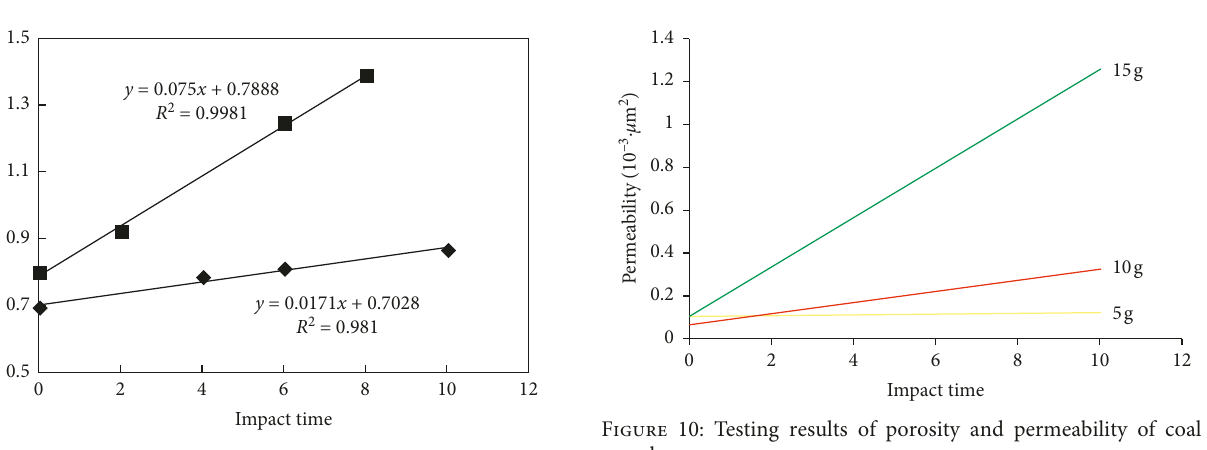
Figure 7: Evolution of microfractures in No. F1 and F3 fat coal samples ( × 20): (a) F1-0; (b) F1-4; (c) F1-6; (d) F1-10; (e) F3-0; (f) F3-2; (g) F3-6; (h) F3-8.